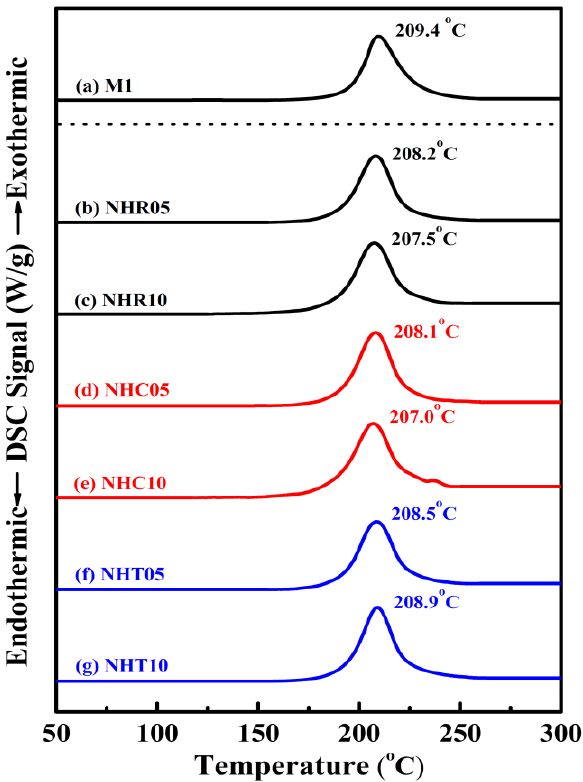
Figure 2. DSC curves of samples ( a ) M1, ( b ) NHR05, ( c ) NHR10, ( d ) NHC05, ( e ) NHC10, ( f ) NHT05, and ( g ) NHT10 at a heating rate of 10 ◦ C min − 1